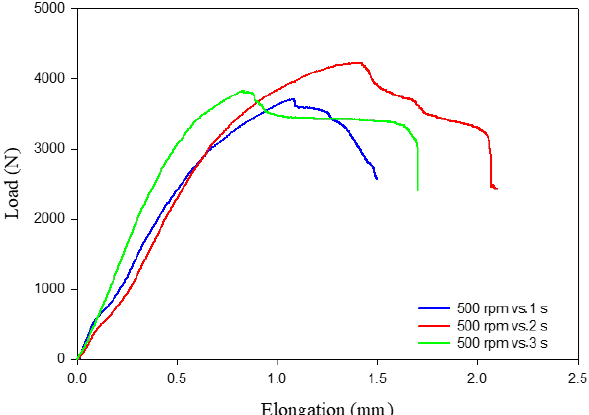
Figure 9. Tensile shear curves of the AA5052-H32 welded joints achieved at 500 rpm rotation speed and dwell times of 1, 2, and 3 s.